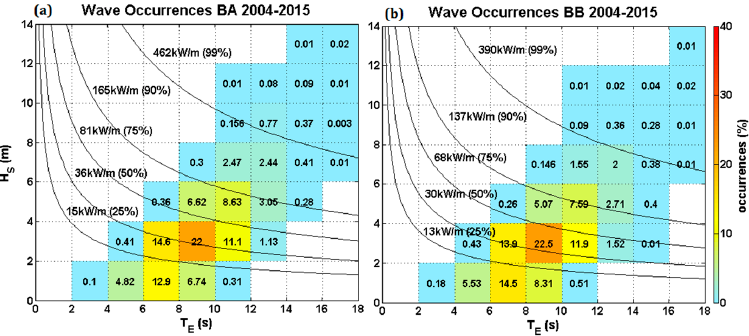
Figure 21. Bi-variate scatter plot for ( a ) BA and ( b ) BB for 2004–2015 showing percentage occurrences of H s and T E , with wave power isolines included.